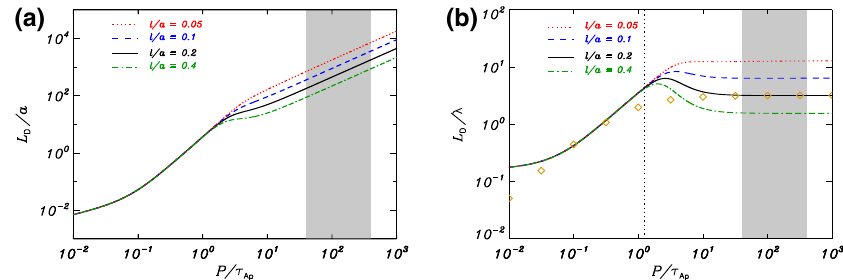
Fig. 77 Results for the kink mode spatial damping in an infinitely long prominence thread, in the case l / a (cid:15)= 0: a L D / a and b L D /λ versus P /τ Ap for l / a = 0 . 05, 0.1, 0.2 and 0.4, with ˜ μ p = 0 . 8. Symbols in ( b ) correspond to the analytical solution in the thin tube approximation, while the vertical dotted line is the approximate transitional period for l / a = 0 . 1. The shaded area denotes the range of observed periods of thread oscillations. Image reproduced with permission from Soler et al. (2011), copyright by AAS